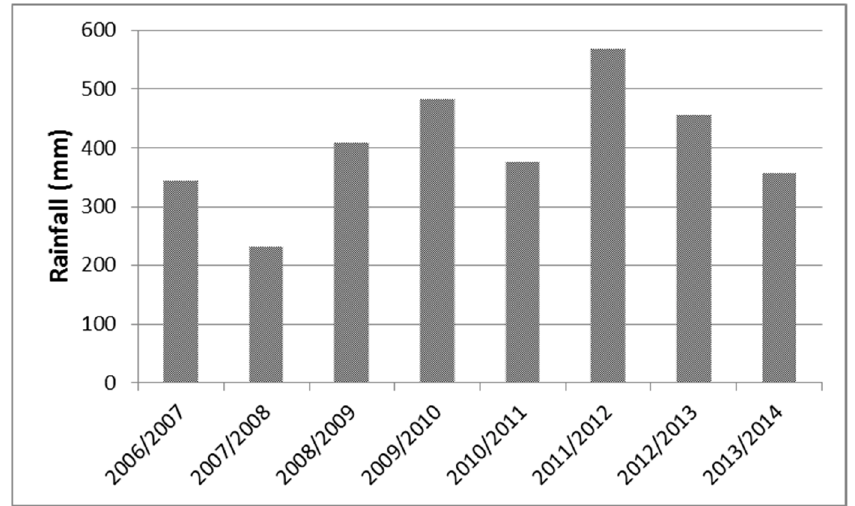
Figure 4. Cropping season (September to May) rainfall obtained from the closest meteorological station for each year of the experimental period.